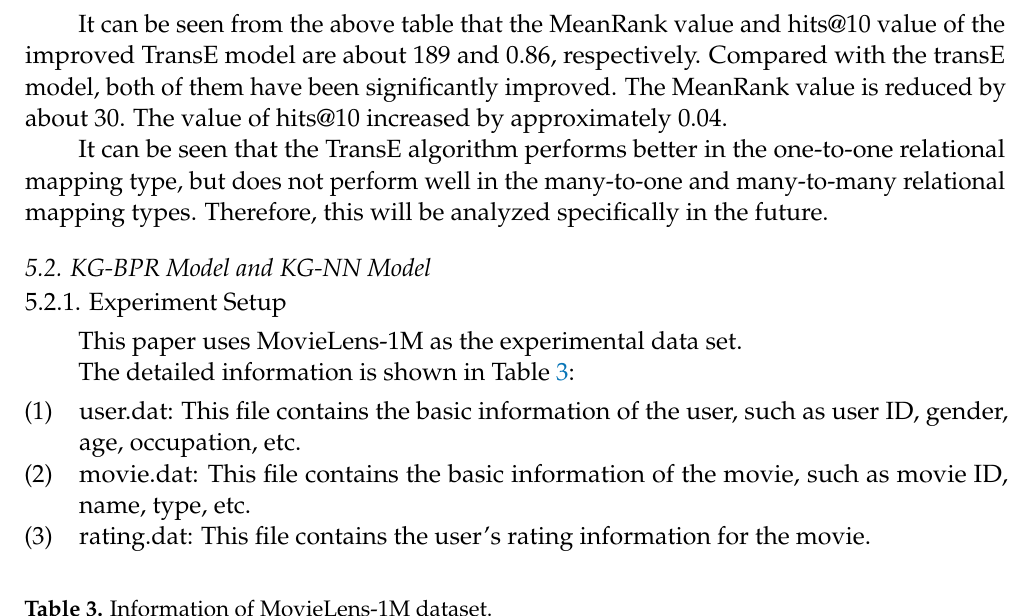
Table 3. Information of MovieLens-1M